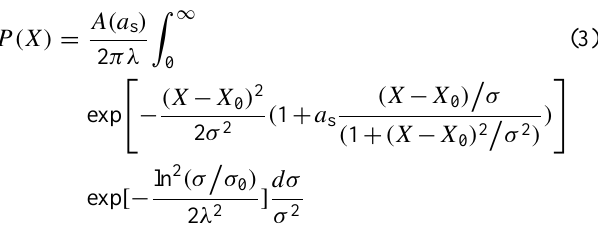
Fig. 2. PDF( δv || ,δ) for δ = 12 1 in (a) and (b) ; δ = 48 1 in (c) and (d) ; δ = 128 1 in (e) and (f) . Solid red curves are from JHU data and blue dash curves are fits with the modified Castaing model, Eq.